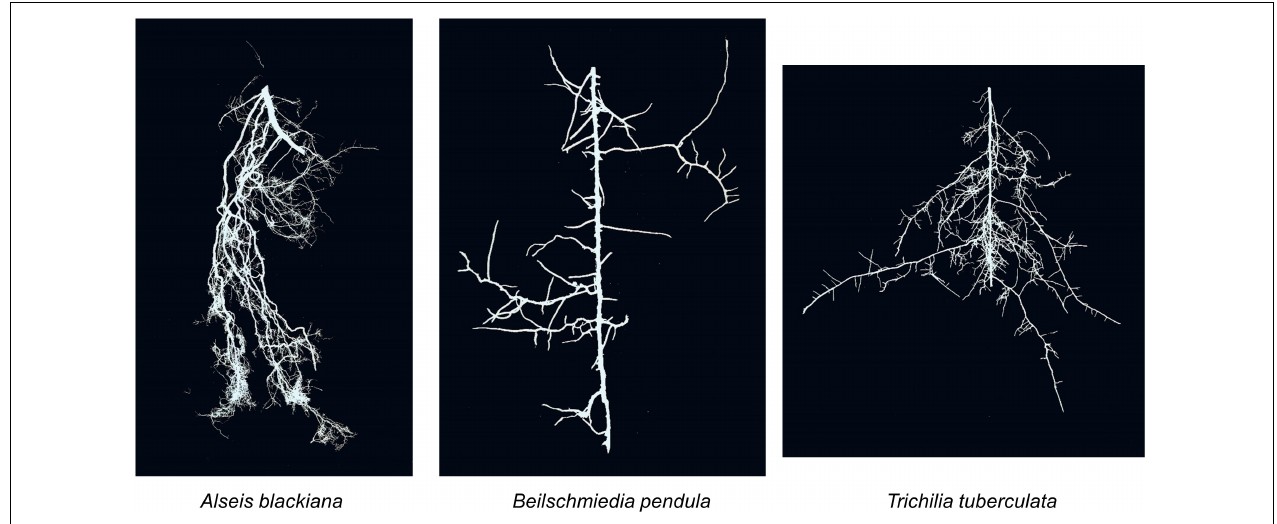
FIGURE 2 | Three contrasting root depth distributions and morphologies are shown for tree species from lowland Panamanian forests. Alseis blackiana Hemsl. ( left ) provides an example of deep biomass depth distributions, roots with high SRL, and high branching ratios, all of which are associated with water acquisition. Beilschmiedia pendula (Sw.) Hensl. ( center ) provides an example of thicker diameter roots and lower root branching ratios, generally associated with a more conservative root strategy and longer turnover times. Trichilia tuberculata (Triana & Planch.) C. DC. ( left ) provides an example of a shallower root depth distribution and high SRL, which can be associated with more fertile soils in tropical sites. Photo credit: S. Bernal and SJ